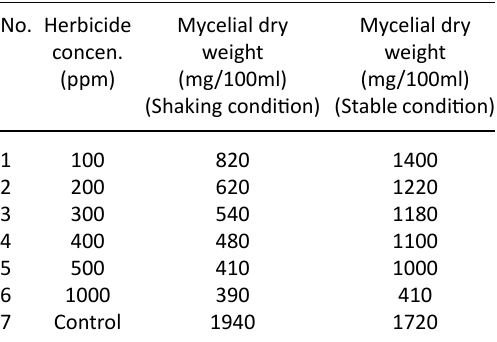
Table 3. Growth of A. terreus in chromium (Chromium III sulphate) amended medium in Shaking and stable